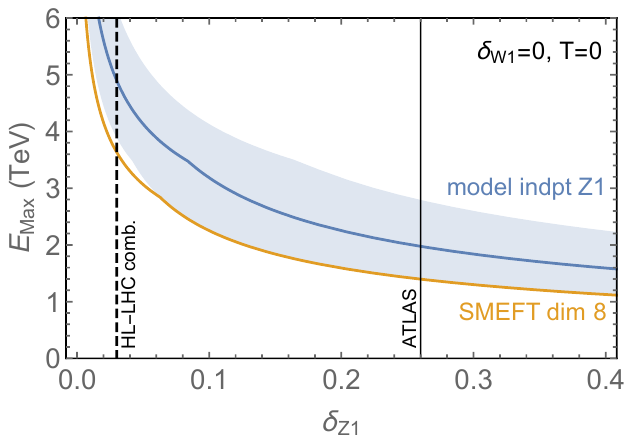
Figure 7 . The unitarity bound as a function of the deviation in the hZZ coupling, assuming δ W 1 = 0 , δT = 0 . The optimal bound lies between the model-independent and SMEFT estimate from the dimension-8 operator eq. (3.14). The band around the model-independent scale results ˆ from varying the unitarity bound to 1 ≤ | M| ≤ 2 . For comparison, we show the 95% C.L. limits 2 on δ from ATLAS [30] and a projected HL-LHC combination Z 1